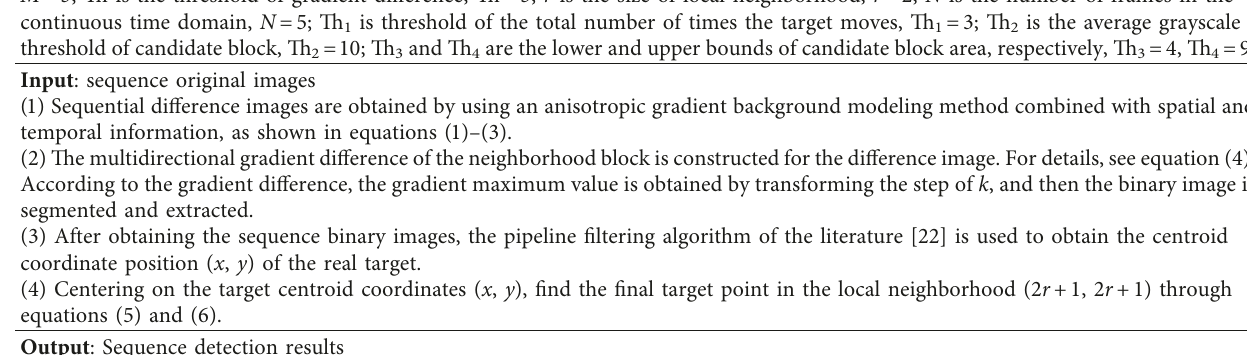
Table 1: Pseudocode of dim small target detection for local energy convergence degree of sequence images.